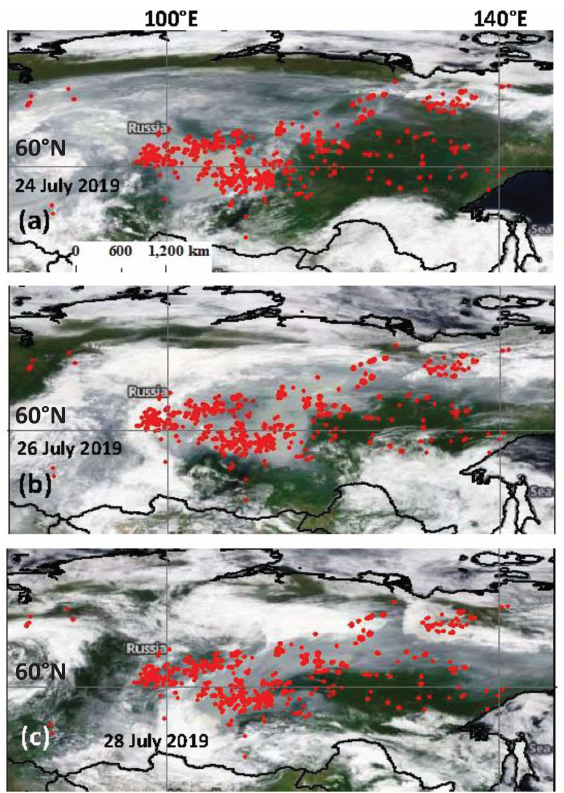
Figure 1. Extended fields of heavy wildfires and large areas covered by smoke (grey areas) north of Lake Baikal (53.5 ◦ N, 108 ◦ E), Rus- sia, in central and eastern Siberia (MODIS, 2021). (a) MODIS over- pass on 24 July 2019, (b) 26 July 2019, and (c) 28 July 2019. White areas indicate cloud layers. Fires detected on the 3d are shown as red dots (FIRMS, 2021).